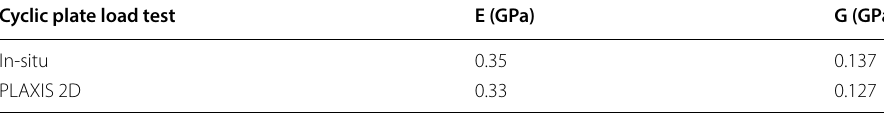
Table 8 The elastic constants obtained from triaxial test Cyclic plate load test E (GPa) G (GPa) In-situ 0.35 0.137 PLAXIS 2D 0.33